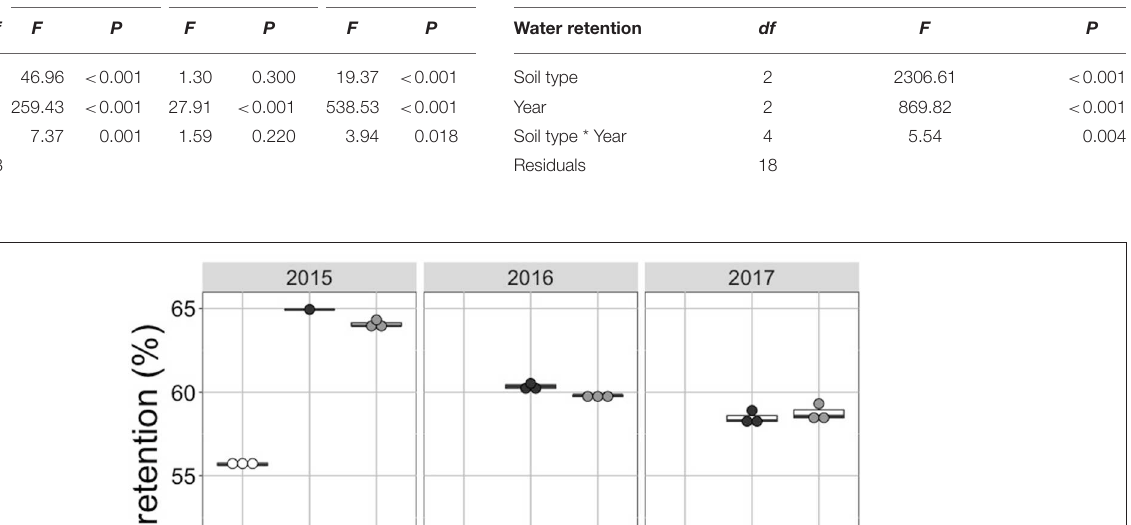
TABLE 2 | Results from analysis of variance (ANOVA) for soil water retention.